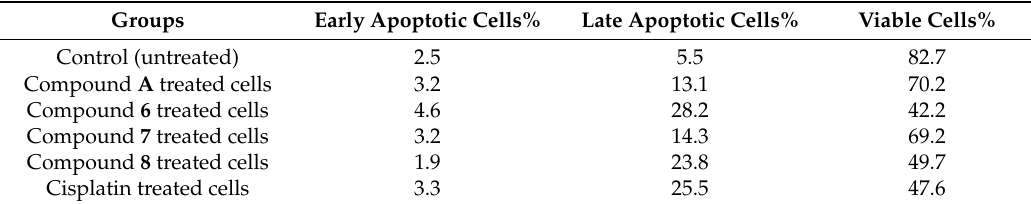
Table 3. Percentages of typical quadrant analysis of Annexin V FITC/Propidium iodide flow cytometry of C6 cells treated with compounds A , 6 , 7 , 8 , and